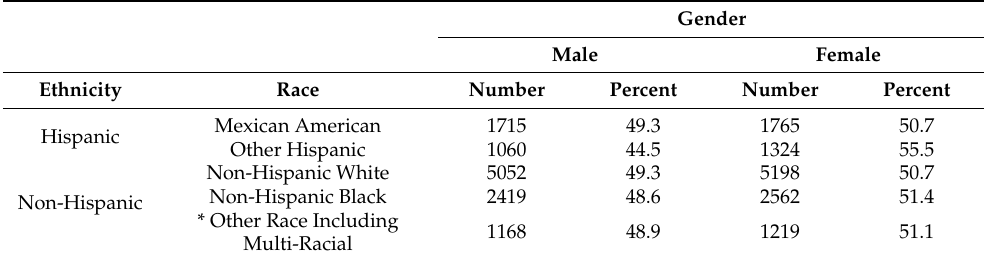
Table 1. The composition and percentage of the ethnicity/race for the participants.